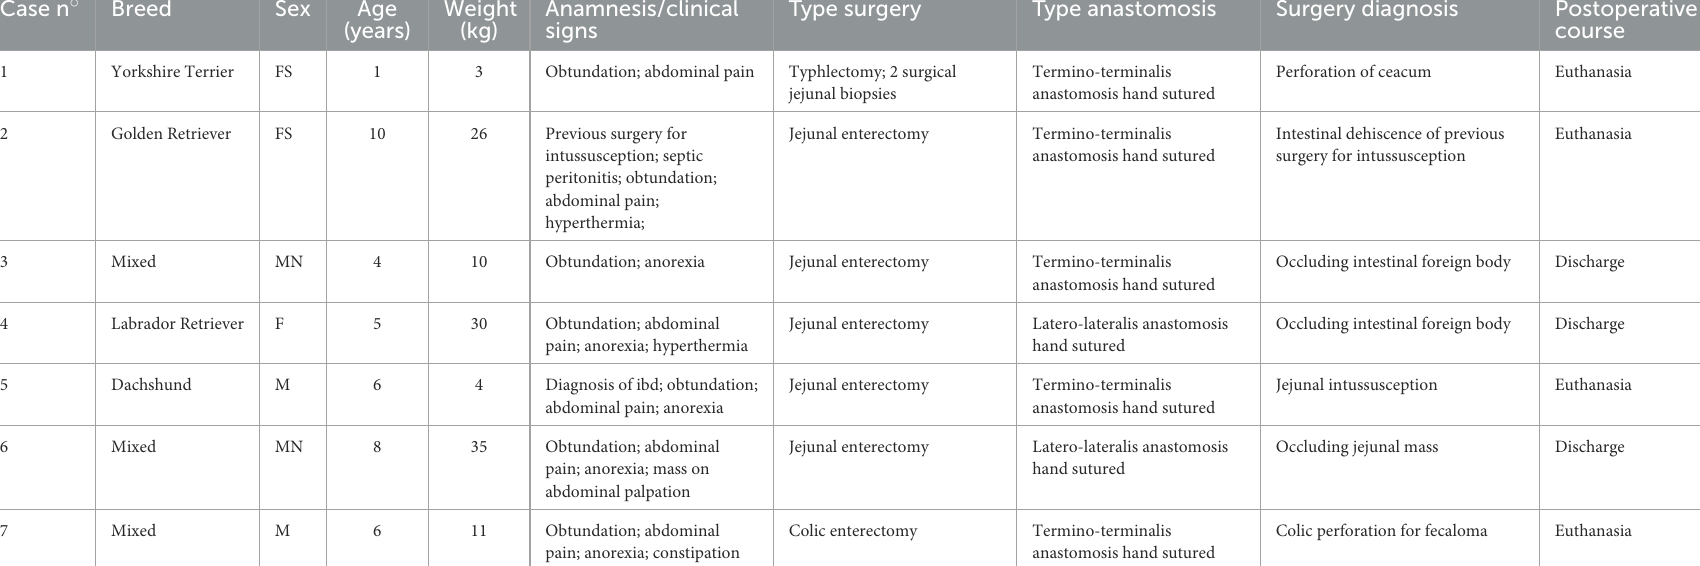
TABLE 1 Signalment, clinical signs, type of surgery and anastomosis of a population of dogs with intestinal dehiscence after intestinal surgery. Case n